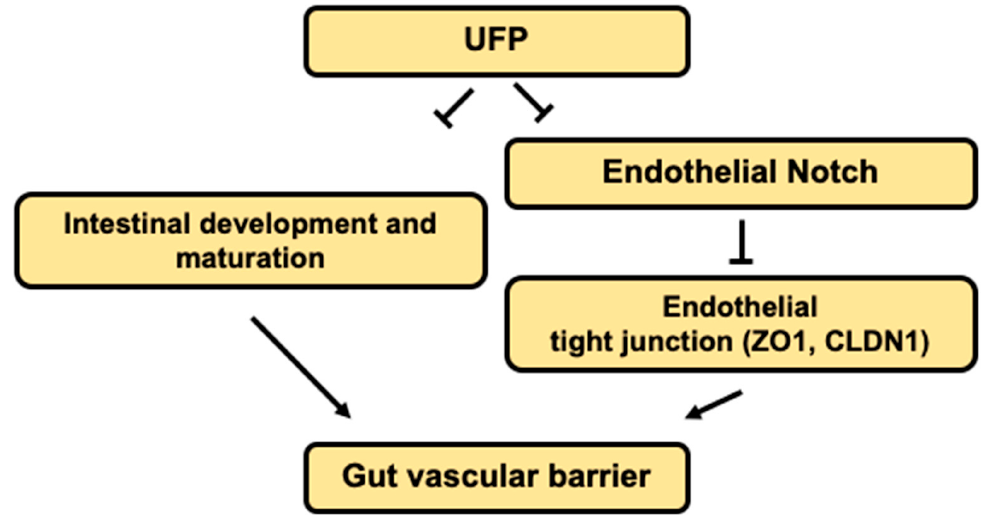
Figure 5. Schematic overviews of the proposed mechanisms.